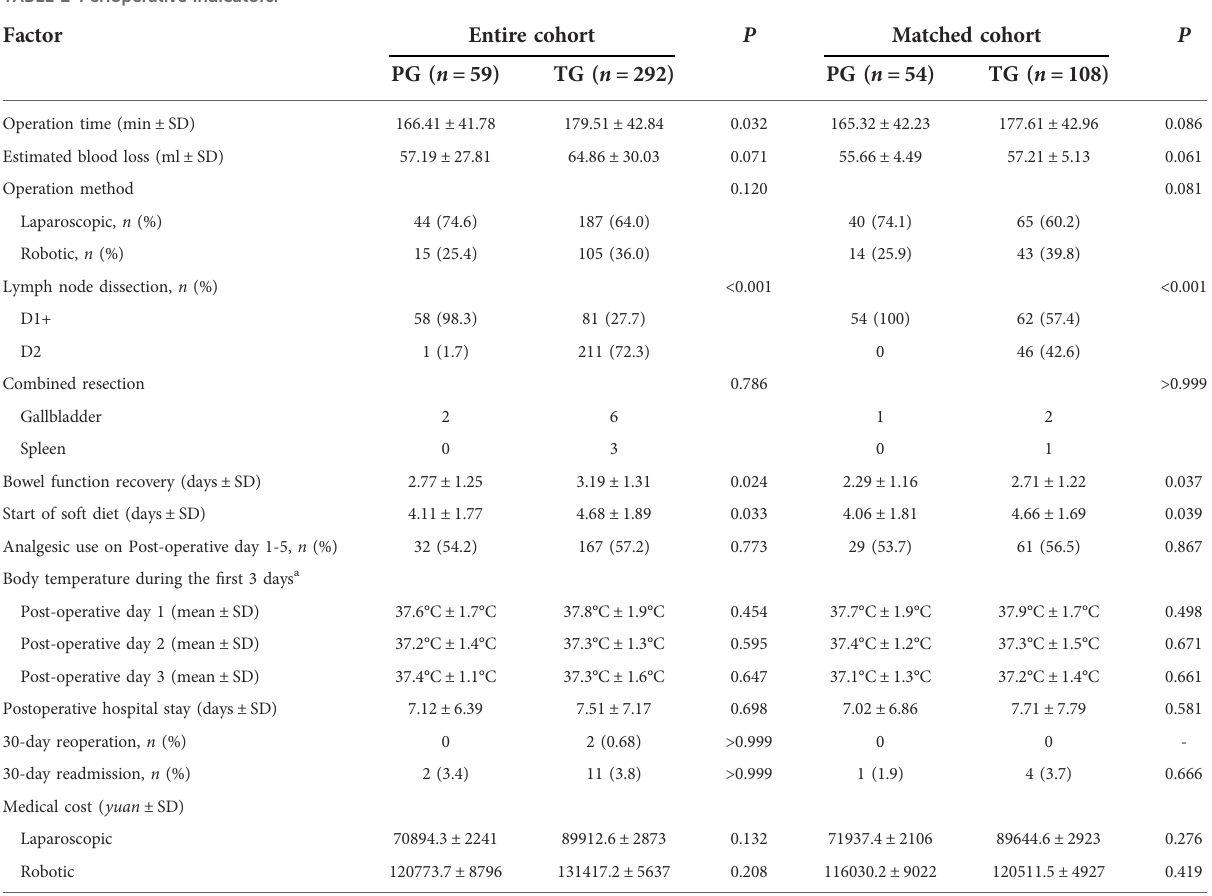
TABLE 2 Perioperative